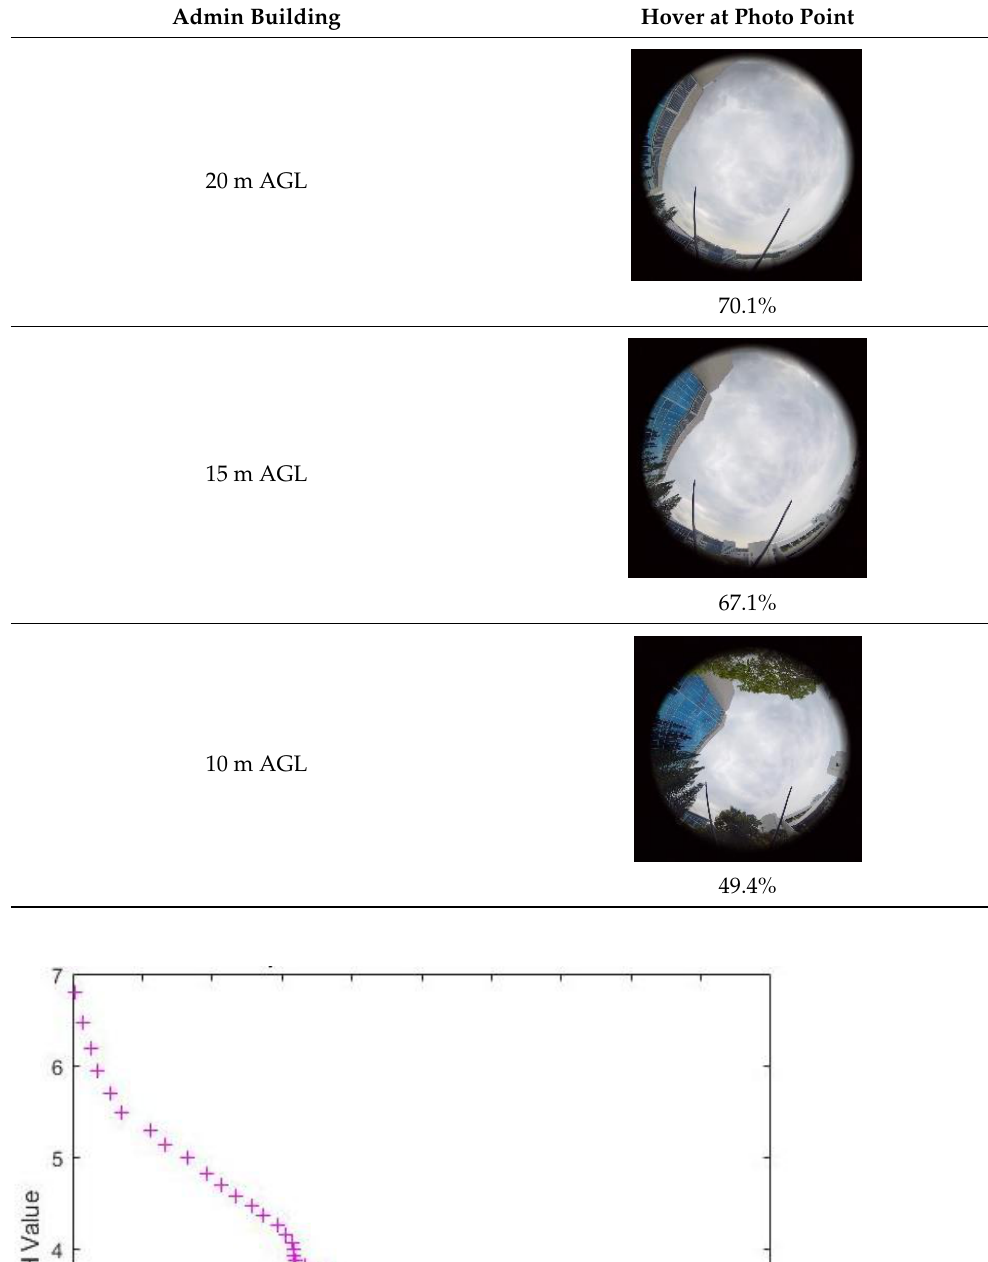
Table 4. Sky Ratio at the Admin Building.